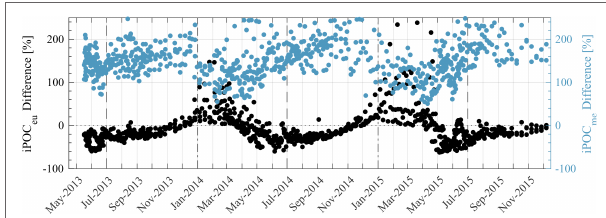
FIGURE 10 | Percent difference between Model A and Model B estimates of iPOC eu and iPOC me from all float profiles described in Figure 7 . For example, iPOC eu percent difference (black) is determined as where superscript “A” or “B” denotes which regression model was used. Note, data is not differentiated by individual